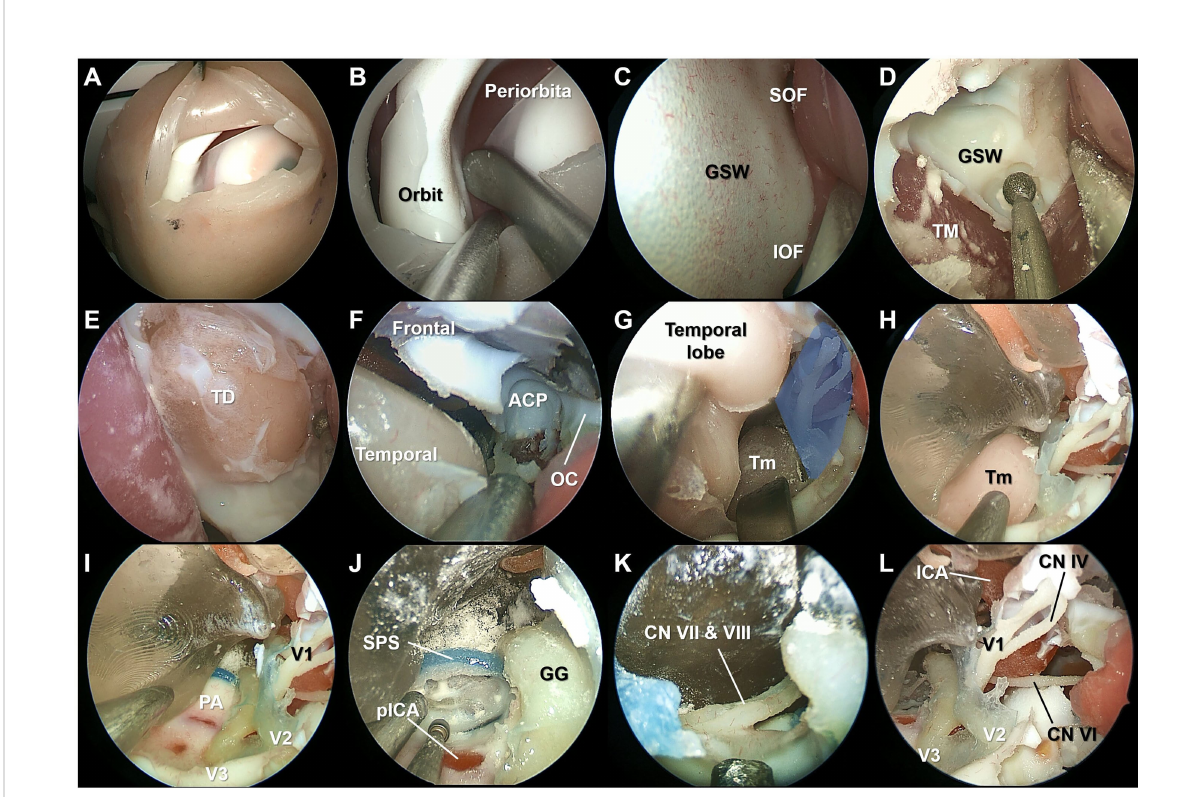
FIGURE 3 Stepwise dissection of the endoscopic transorbital surgery procedures using the simulation model. The superior eyelid incision was made on the simulation model (A) . Subperiosteal elevation of the periorbital was performed (B) . After identifying the superior (SOF) and inferior orbital fi ssure, the ocular surface of the greater sphenoidal wing was drilled to expose the middle cranial fossa (C, D) . The temporal dura was exposed, and the bone composing the lateral border of the SOF and maxillary strut was completely removed (E, F) . The lateral wall of the cavernous sinus (CS) (blue shaded area) was peeled off from the dura propria of the temporal lobe, and the tumor (Tm) lesion reconstructed from the patient with a trigeminal schwannoma was identi fi ed (G, H) . The ophthalmic branch (V1), maxillary branch (V2), and mandibular branch (V3) of the trigeminal nerve were identi fi ed after resection of the Tm (I) . Anterior petrosectomy was performed, and the seventh and eighth cranial nerves were identi fi ed (J, K) . The lateral wall of the CS was opened, and the neurovascular structures were identi fi ed (L) . TM, temporalis muscle; ACP, anterior clinoid process; OC, optic canal; PA, petrous apex; SPS, superior petrosal sinus; pICA, petrous segment of the internal carotid artery; GG, Gasserian